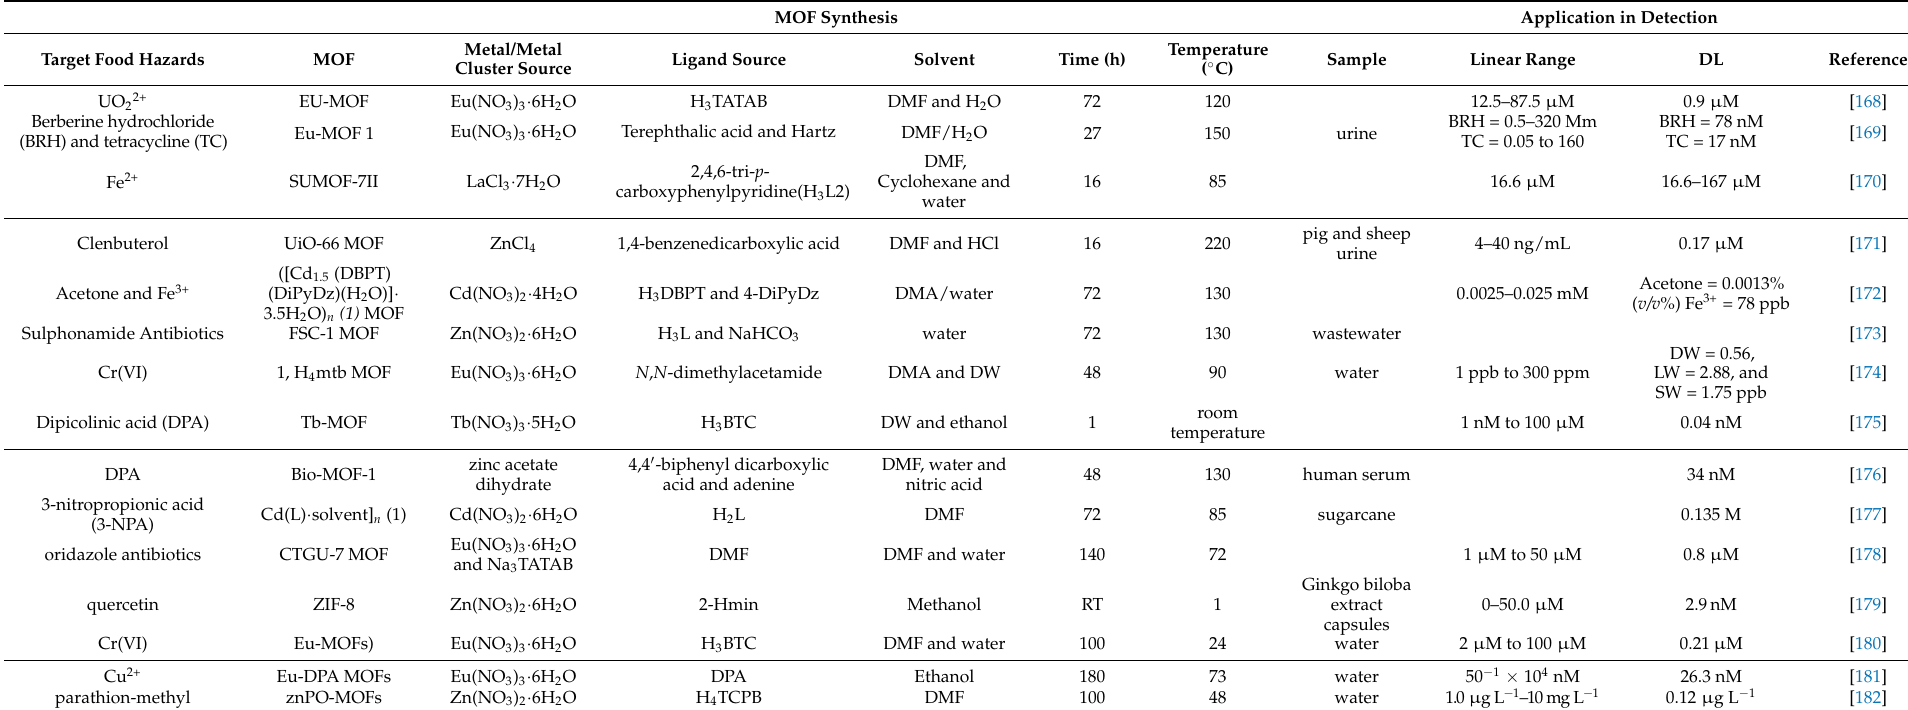
Table 3. Sensing application of the MOF-based luminescence chemosensing method for food safety